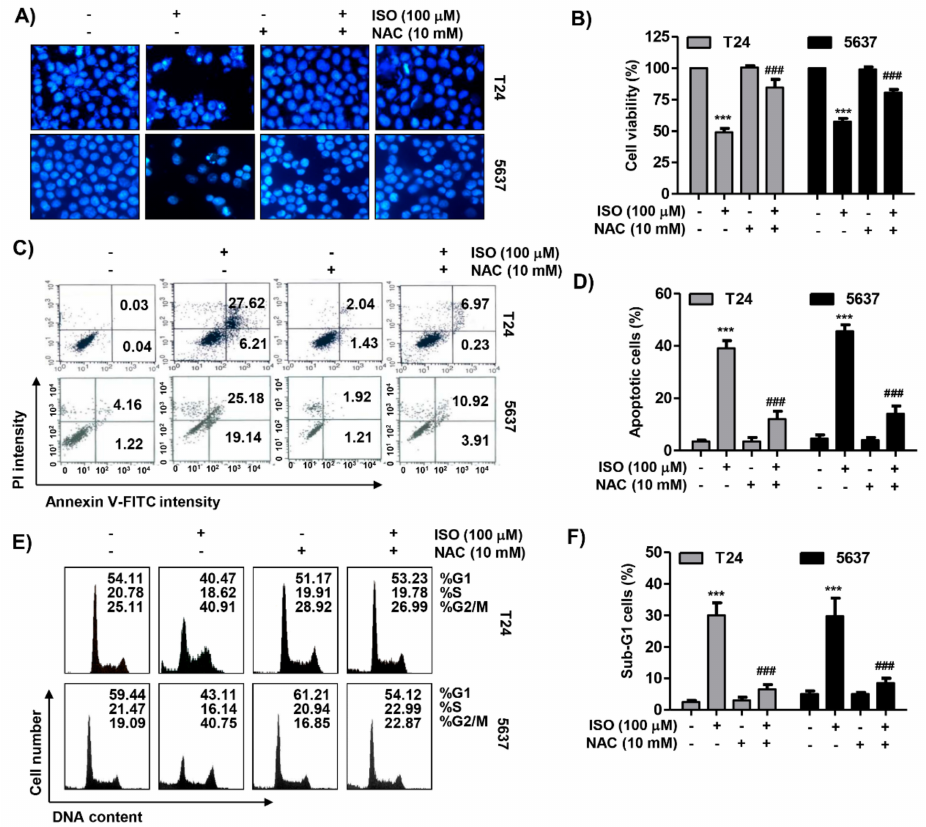
Figure 7. Roles of ROS in isorhamnetin-induced apoptosis and cell cycle arrest in bladder cancer cells. Cells were either treated with 100 µ g / mL isorhamnetin for 48 h or pre-treated with 10 mM NAC for 1